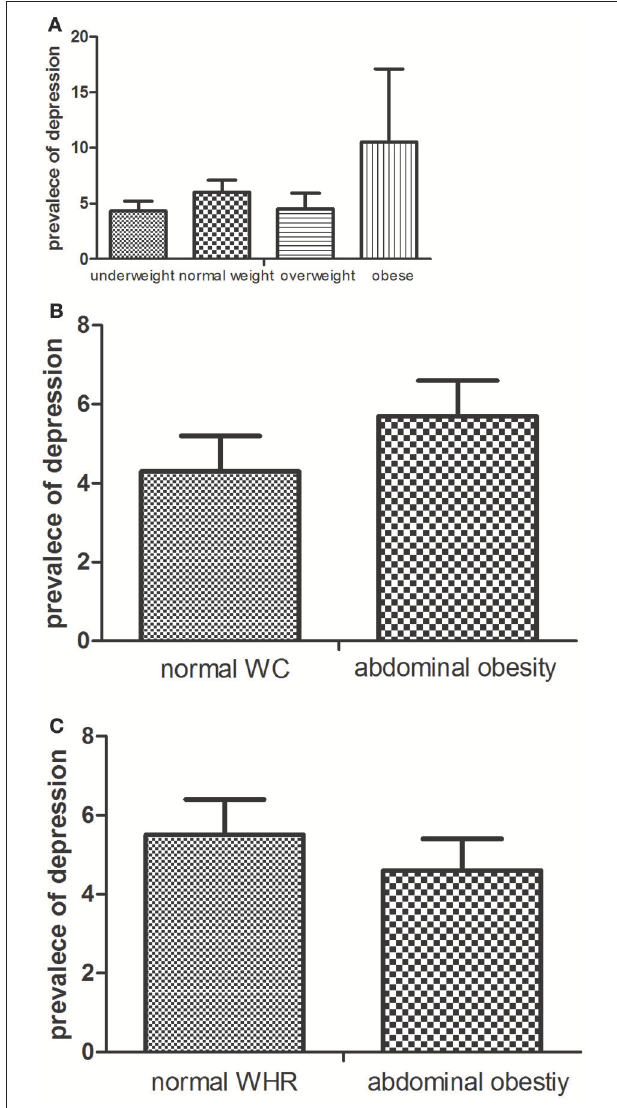
FIGURE 1 | The age-standardized prevalence (%) of depression according to BMI (A) , WC (B) , and WHR (C)